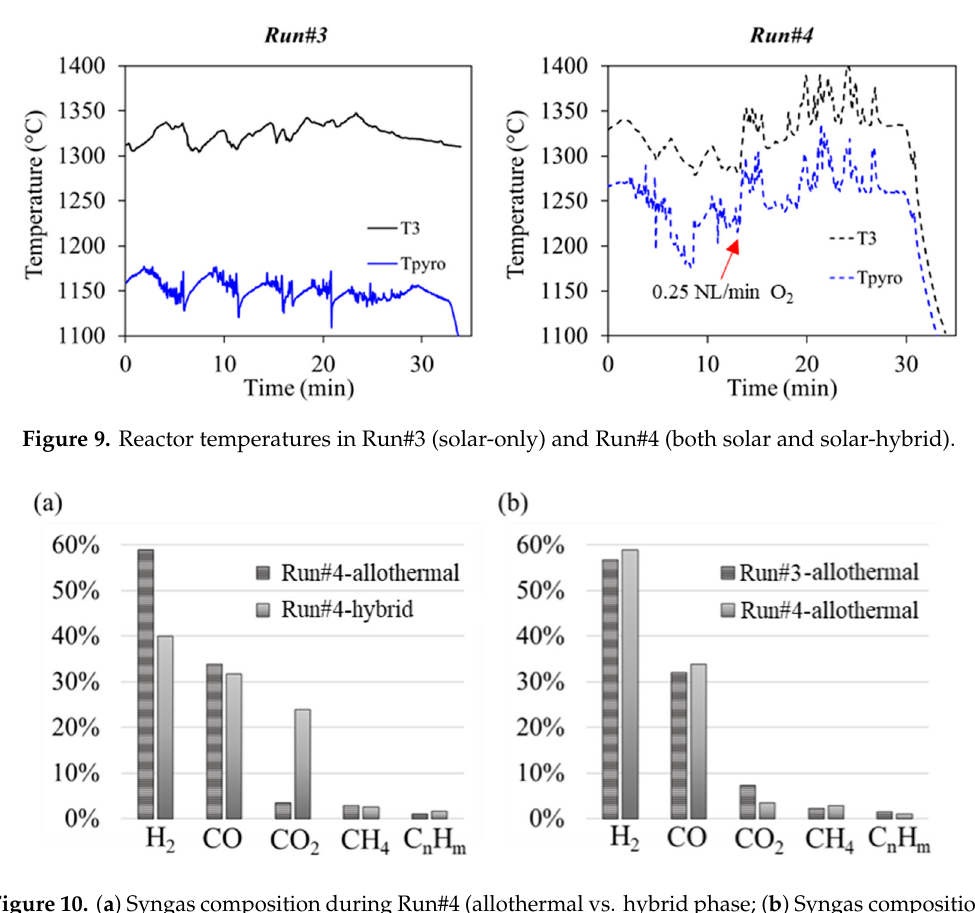
Figure 10. ( a ) Syngas composition during Run#4 (allothermal vs. hybrid phase; ( b ) Syngas composition (Run#3 vs. allothermal part of Run#4).